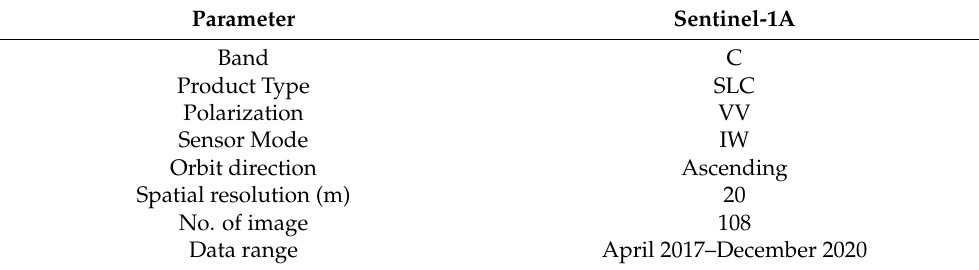
Table 1. Properties of the Sentinel-1A dataset.